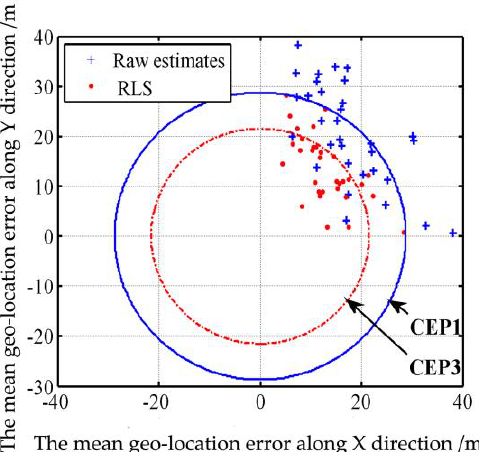
Figure 15. Sample distribution of target location before and after RLS.